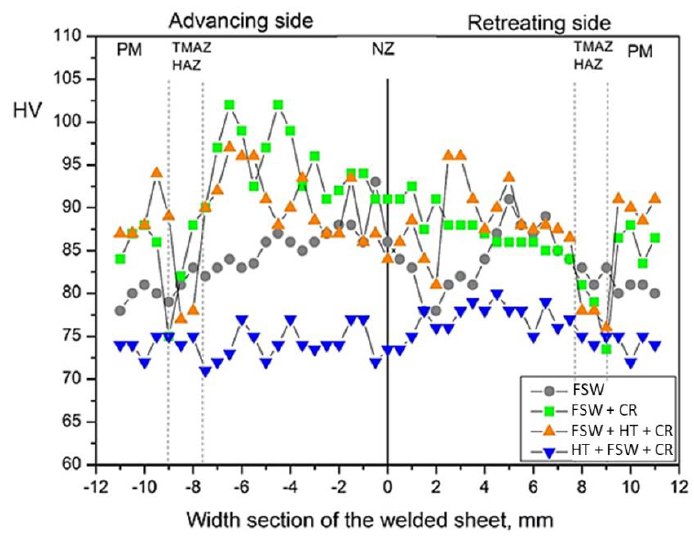
Figure 8. Microhardness profile of the welded joint, for the FSW processing conditions B.